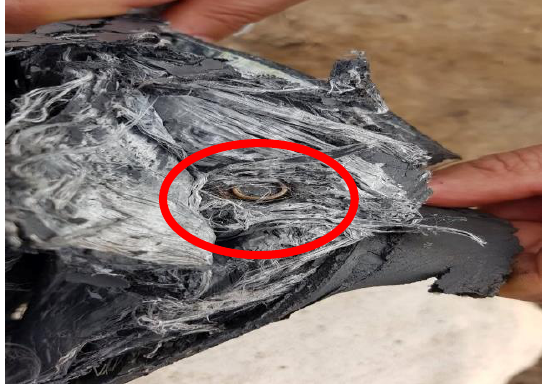
Fig.4: The ballistic test by handgun bullets of 9*19 mm from a distance of 10